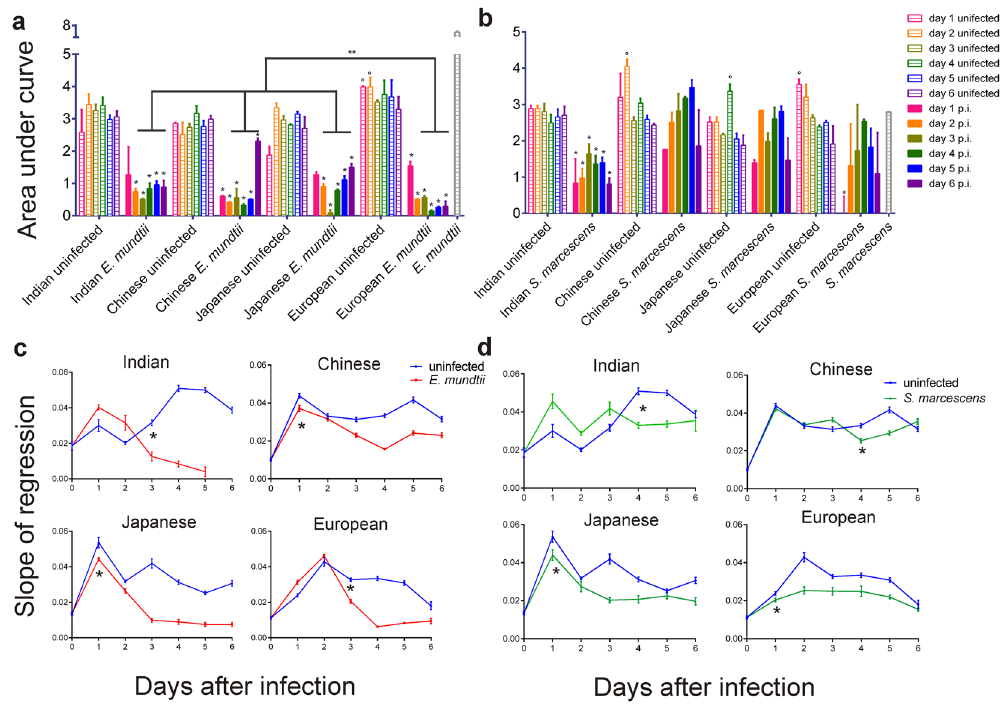
Figure 3. Plasma antimicrobial activity and melanization rate in the four B . mori strains during six days after E . mundtii or S . marcescens infections. ( a , b ) In vitro E . mundtii ( a ) or S . marcescens ( b ) growth in E . mundtii ( a ) or S . marcescens ( b ) infected plasma and relative uninfected controls, for six days after bacterial challenge. The bacterial growth is evaluated as Area under curve between 3 and 9 h post - inoculum (mean ± SEM; nine plasma samples in three replicates per time per condition); p.i.: post-infection. In ( a ) two-way ANOVA revealed significant variations in infected vs uninfected samples for each strain (effect of condition: p < 0.0001 for all strains). * Indicates significant differences between infected vs uninfected samples from the same day within the same strain (Bonferroni post - hoc test; p < 0.05). ** Indicates significant differences between infected plasma of the different strains (two-way ANOVA p < 0.0001). In ( b ) two-way ANOVA revealed significant variations in infected vs uninfected samples in the Indian strain (effect of condition: p < 0.0001) and in the plasma from the first day after infection in the European strain (p < 0.005). * Indicates significant differences between infected vs uninfected samples from the same day (Bonferroni post - hoc test; p < 0.05). In ( a , b ) °indicates sporadic significant differences among samples from the same day in uninfected strains (statistical details in Supplementary Tables S2 and S3); ( c , d ) Melanization rate of E . mundtii ( c ) or S . marcescens ( d ) infected plasma and relative uninfected controls, for six days after bacterial challenge. Slopes of melanization regression lines are calculated for each condition (mean ± SEM; nine plasma samples in three replicates per time per condition). Two-way ANOVA revealed significant variations in infected vs uninfected samples for each strain [effect of condition: p < 0.0001 for all the four strains (statistical details in Supplementary Table S4 and S5)]. * Significant lower melanization rates in infected plasma compared to the relative uninfected controls evaluated in Bonferroni post - hoc test (p <